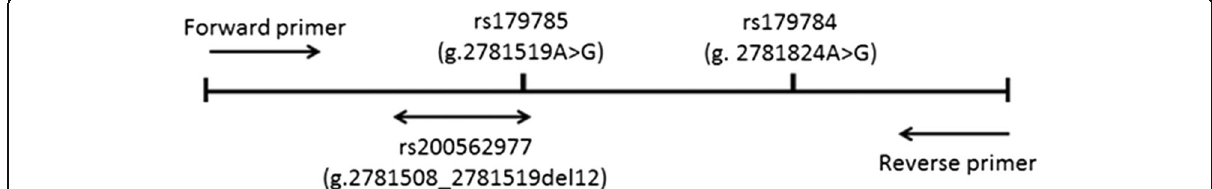
Fig. 3 Location of three variants: rs179785, rs200562977 and rs179784 of KCNQ1 . rs179785 (A/G) is located at the last nucleotide, “ A ” , of the 12-bp deletion site on rs200562977 (g.2781508_2781519del12GGCGGGCAGGCA). rs179784 is located 305 bp downstream from rs179785 and shows strong linkage disequilibrium with rs179785 ( D ’ =1.0 and r 2 =0.99). For direct sequencing of the three variants of KCNQ1 , the primers were designed as follows: 5 ’ -ACTTCCTGCCTCTGCTTTC-3 ′ (forward primer) and 5 ’ -TGAAGGAAGTGACCCCTG-3 ′ (reverse primer), respectively